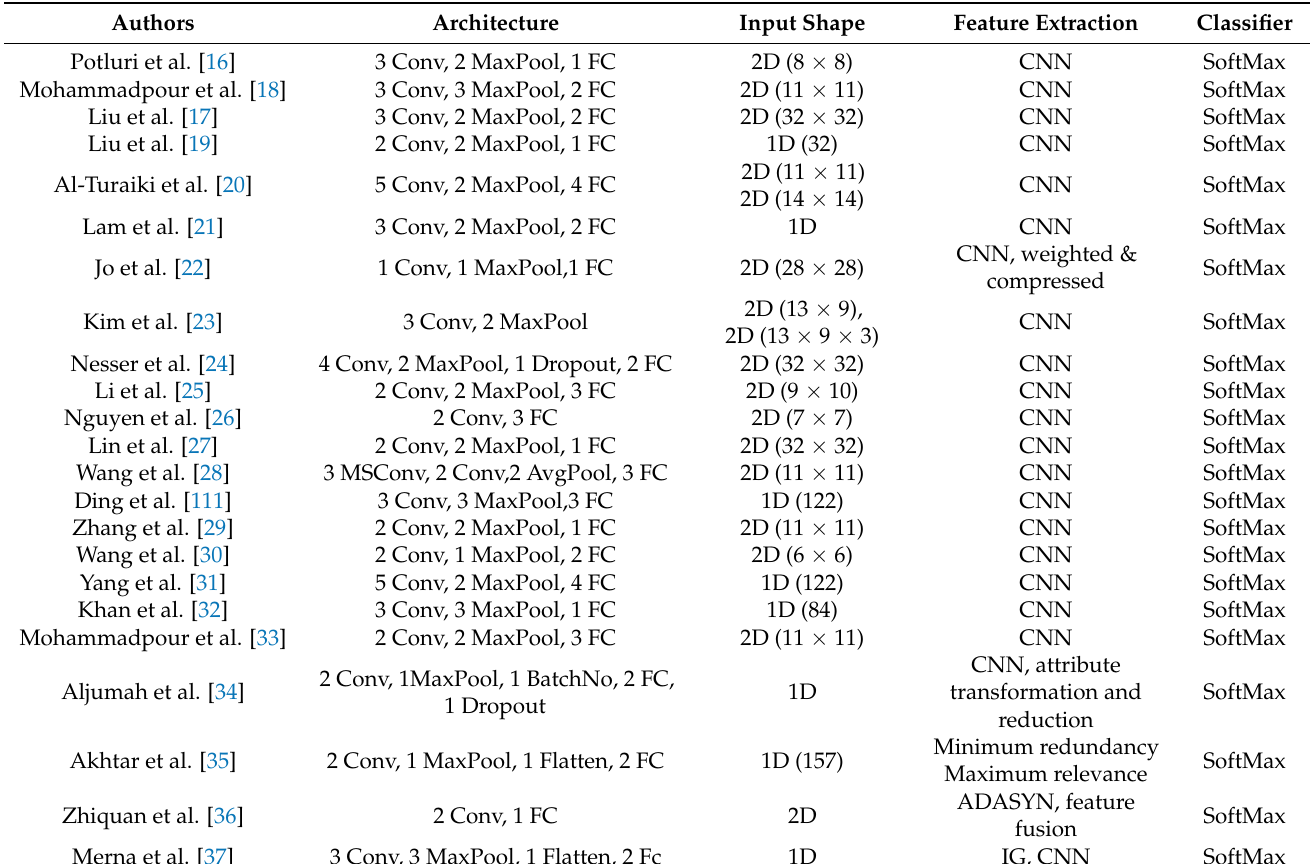
Table 6. Architectural properties of group 1 (Single CNN-Based) IDS schemes.